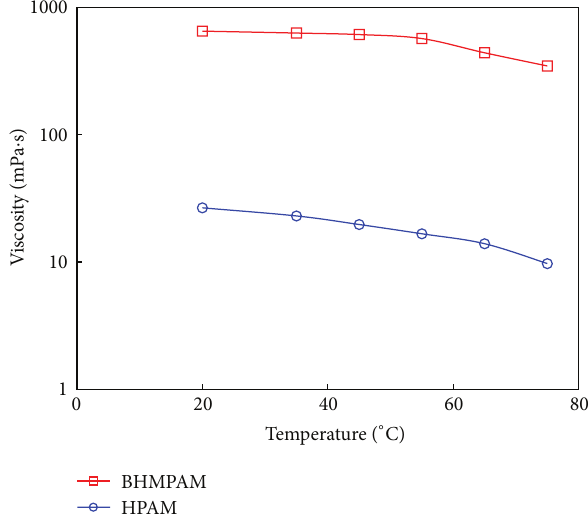
Figure 3: Viscosity versus temperature of BHMPAM compared to HPAM in synthetic formation water (concentration of both polymers: 1750 mg/L).